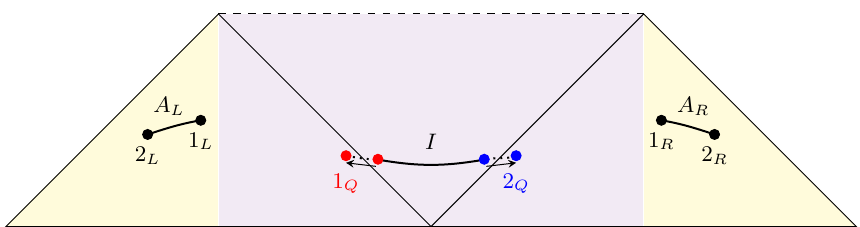
( b − a ) , they remain 2